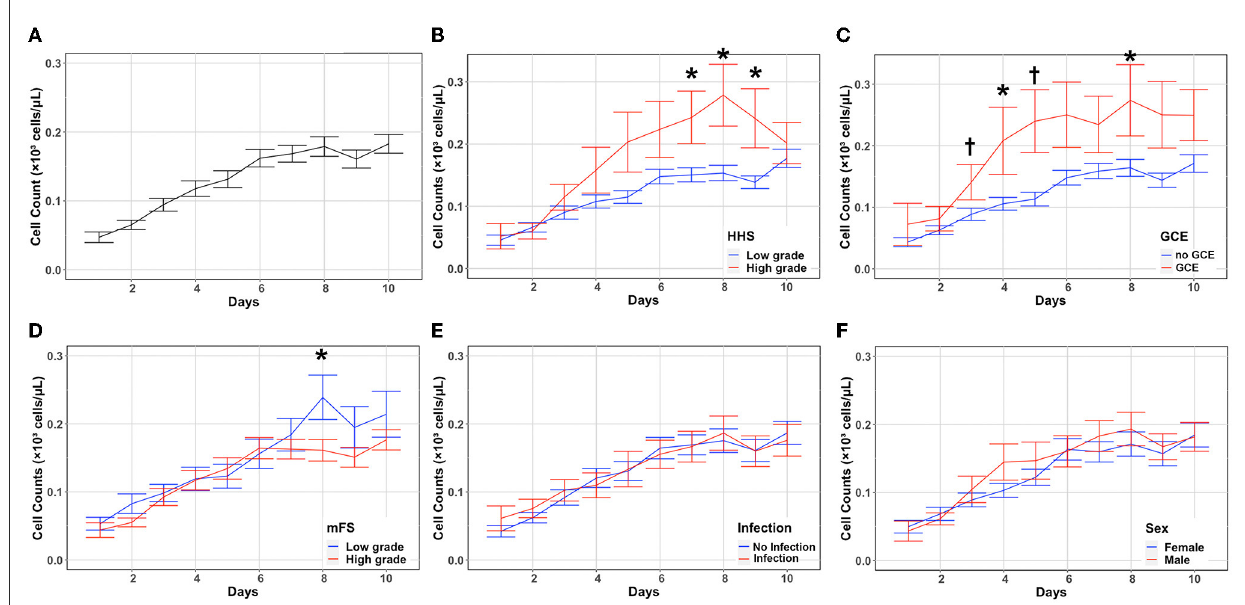
FIGURE1 Absolute eosinophil count changes and association with disease severity. Eosinophil counts (mean and standard deviation) are shown from the day of aneurysmal rupture (Day 0) through day 10 (A) . Cells are in units of 1,000 per mm 3 . Counts were stratified by HHS (B) , GCE (C) , mFS (D) , infection (E) , and sex (F) . * P < 0.05, † P < 0.001. GCE, global cerebral edema; HHS, hunt–hess scale; mFS, modified fisher scale.